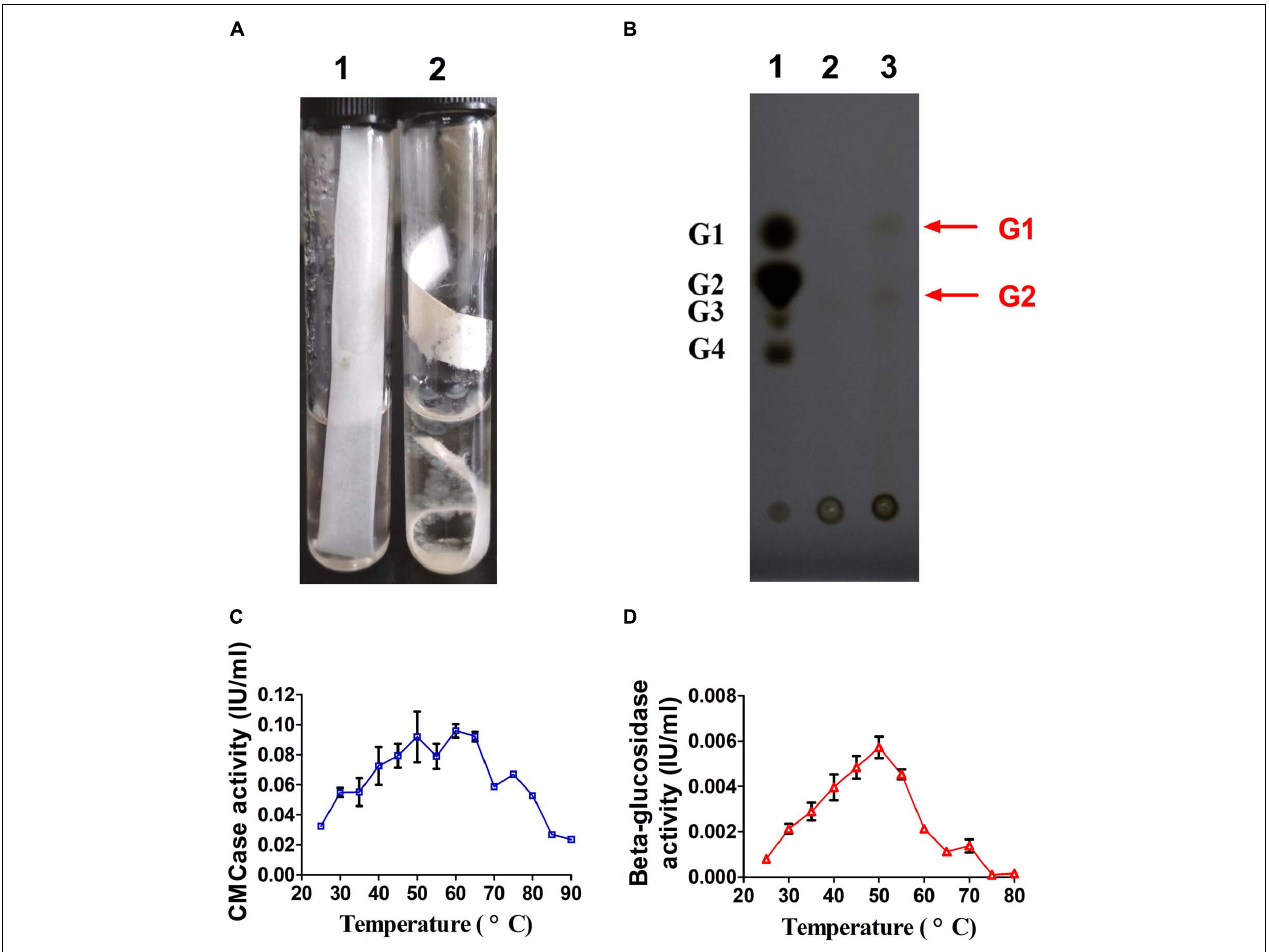
FIGURE 2 | Cellulase activity of A. amylolytica YIM strain 77502 T . (A) Hydrolysis experiment using filter paper. (B) Thin-layer chromatography plate analysis of hydrolytic products of carboxyl methyl cellulose (CMC) in fermentation broth of A. amylolytica , which was cultured with microcrystalline cellulose. (C) CMCase